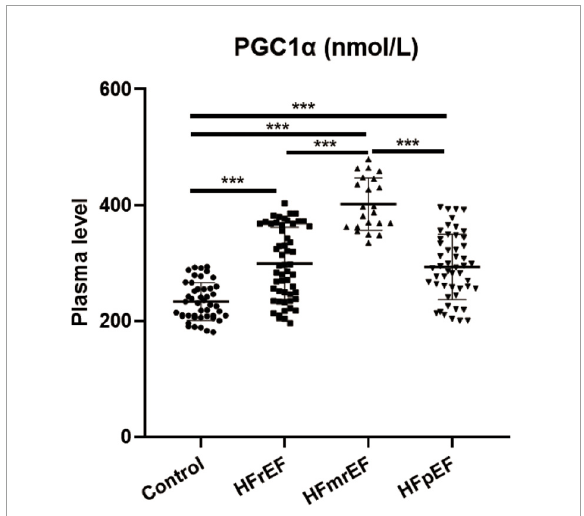
FIGURE2 PGC1 α expression in different HF phenotypes. PGC1 α , peroxisome proliferator-activated receptor- γ coactivator-1 α ; Control, non-heart failure participants; HFrEF, heart failure with reduced ejection fraction; HFmrEF, heart failure with mildly reduced ejection fraction; HFpEF, heart failure with preserved ejection fraction. *** P <